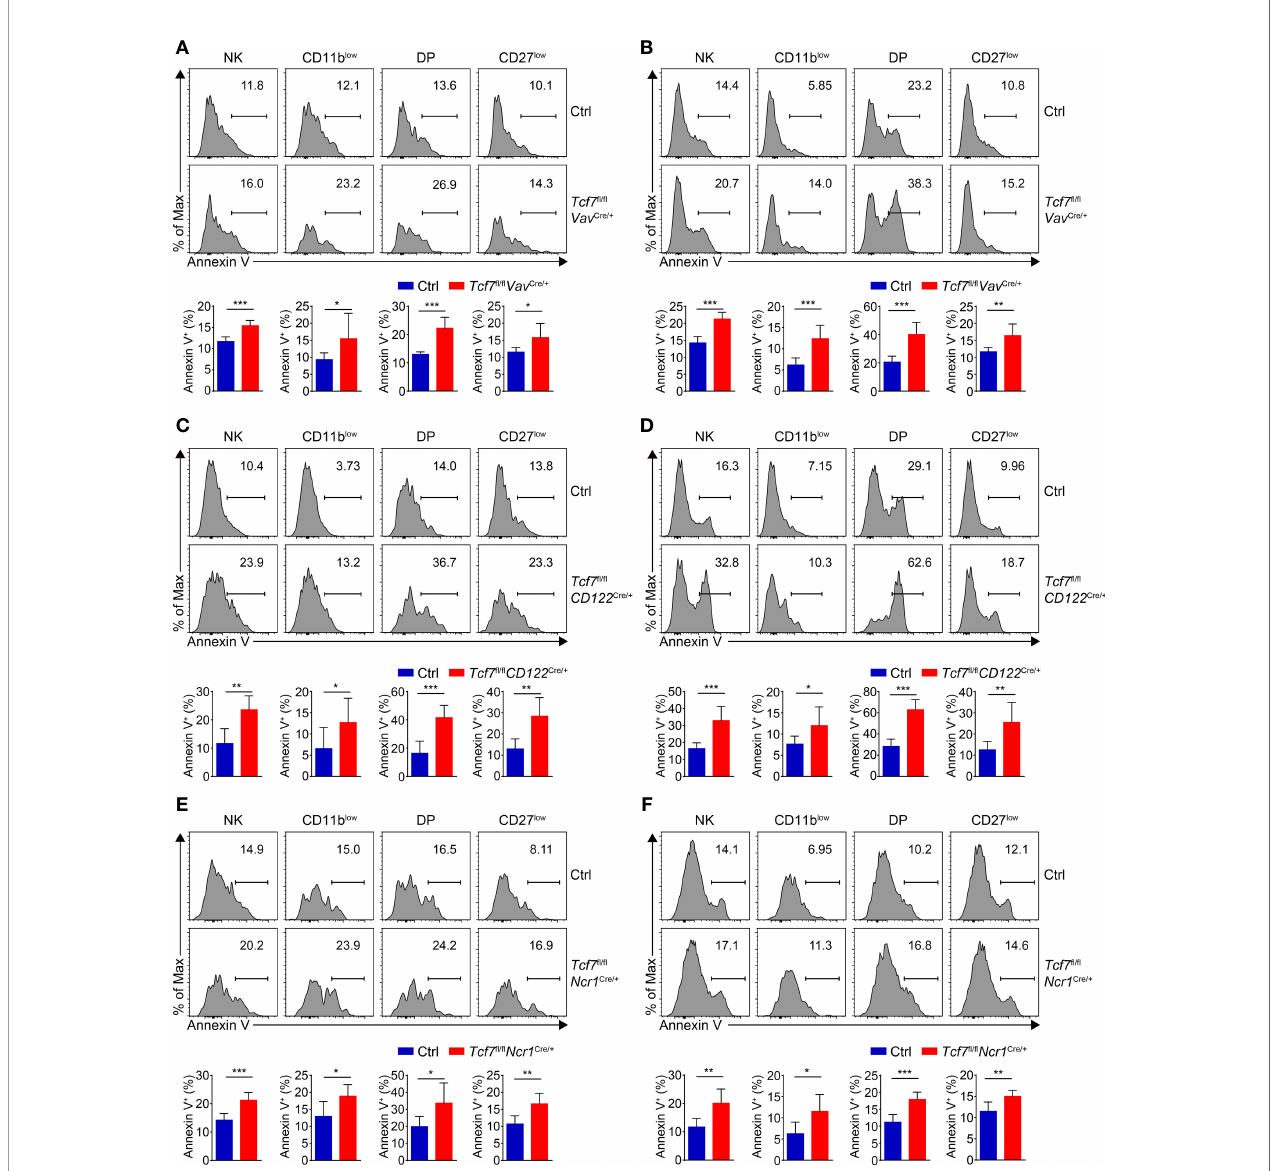
FIGURE 5 | Analyzing the NK cell survival in the three mouse models. (A) Analyzing apoptosis of NK subsets in BM from Ctrl and Tcf7 fl / fl Vav Cre/+ mice. Representative histograms showed the Annexin V + cells of CD11b low , DP, and CD27 low NK subsets (upper panel). Frequency of Annexin V + cells in indicated subsets is shown (lower panel), accordingly (n ≥ 6 for each group). (B) Analyzing apoptosis of NK subsets in SP from Ctrl and Tcf7 fl / fl Vav Cre/+ mice. Representative histograms showed the Annexin V + cells of CD11b low , DP, and CD27 low NK subsets (upper panel). Frequency of Annexin V + cells in indicated subsets is shown (lower panel), accordingly (n ≥ 6 for each group). (C) Analyzing apoptosis of NK subsets in BM from Ctrl and Tcf7 fl / fl CD122 Cre/+ mice. Representative histograms showed the Annexin V + cells of CD11b low , DP, and CD27 low NK subsets (upper panel). Frequency of Annexin V + cells in indicated subsets is shown (lower panel), accordingly (n ≥ 6 for each group). (D) Analyzing apoptosis of NK subsets in SP from Ctrl and Tcf7 fl / fl CD122 Cre/+ mice. Representative histograms showed the Annexin V + cells of CD11b low , DP, and CD27 low NK subsets (upper panel). Frequency of Annexin V + cells in indicated subsets is shown (lower panel), accordingly (n ≥ 6 for each group). (E) Analyzing apoptosis of NK subsets in BM from Ctrl and Tcf7 fl / fl Ncr1 Cre/+ mice. Representative histograms showed the Annexin V + cells of CD11b low , DP, and CD27 low NK subsets (upper panel). Frequency of Annexin V + cells in indicated subsets is shown (lower panel), accordingly (n ≥ 6 for each group). (F) Analyzing apoptosis of NK subsets in SP from Ctrl and Tcf7 fl / fl Ncr1 Cre/+ mice. Representative histograms showed the Annexin V + cells of CD11b low , DP, and CD27 low NK subsets (upper panel). Frequency of Annexin V + cells in indicated subsets is shown (lower panel), accordingly (n ≥ 6 for each group). All data were pooled from at least two independent experiments. Statistical signi fi cance was determined by one-tailed Student ’ s t-test. * P < 0.05, ** P < 0.01, and *** P < 0.001. Data are means ±